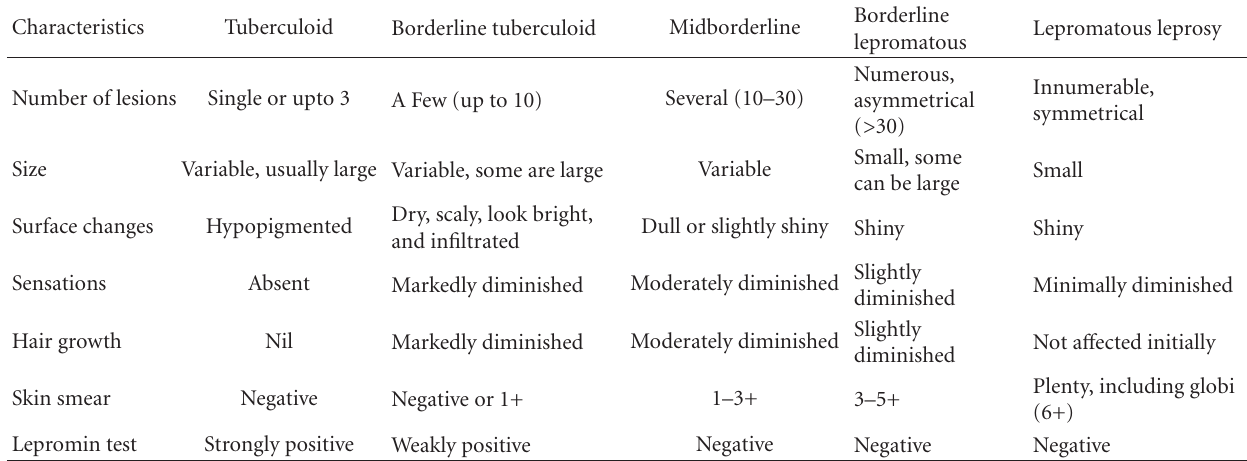
Table 1: Clinical features of